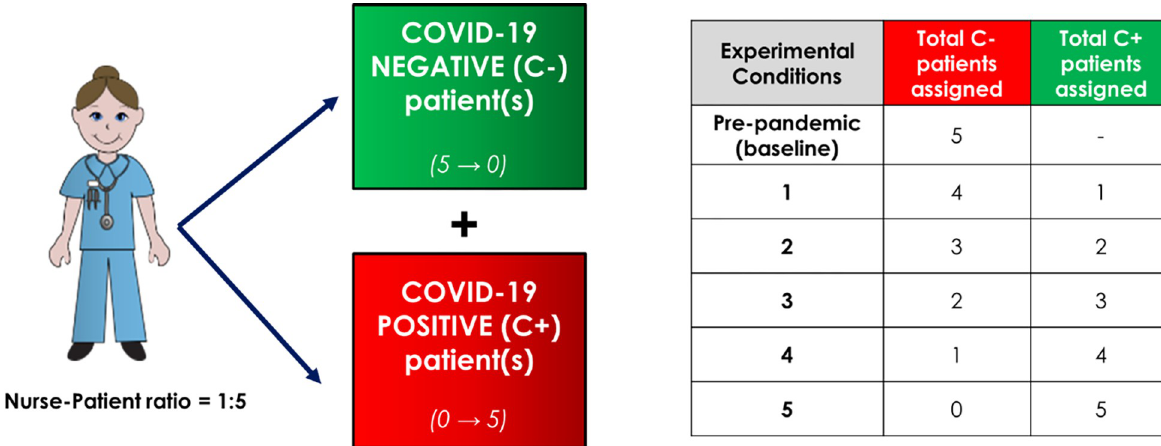
Fig 2. The experimental design conditions: A nurse assigned to the sum of C+ and C- negative patients where, zero C+ and five C- patients is the baseline (pre-pandemic) case. A nurse-patient ratio of 1:5 was kept for all conditions.